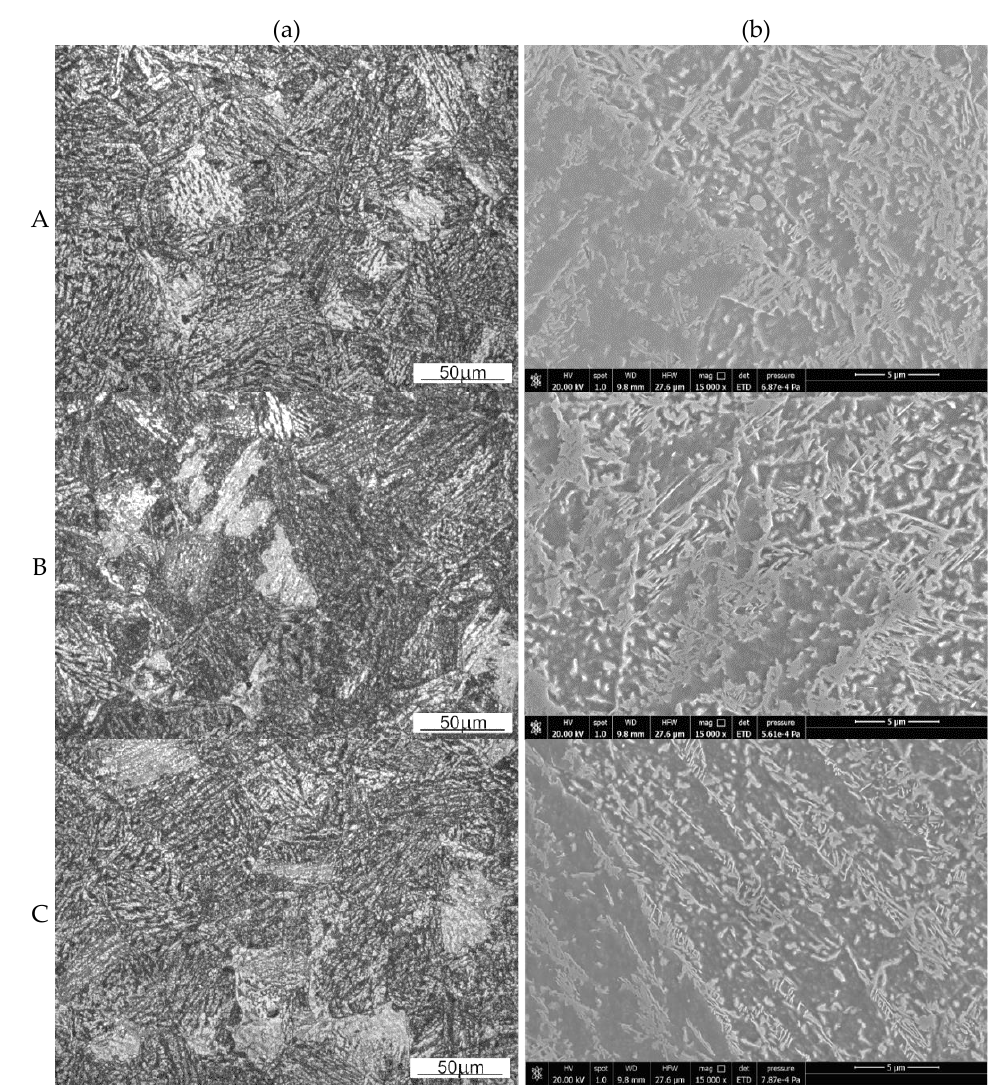
Figure 7. The microstructure of the 4130-steel flange in pre-selected points of the microstructure observations ( A – C ): ( a ) light microscope, ( b ) scanning microscope.